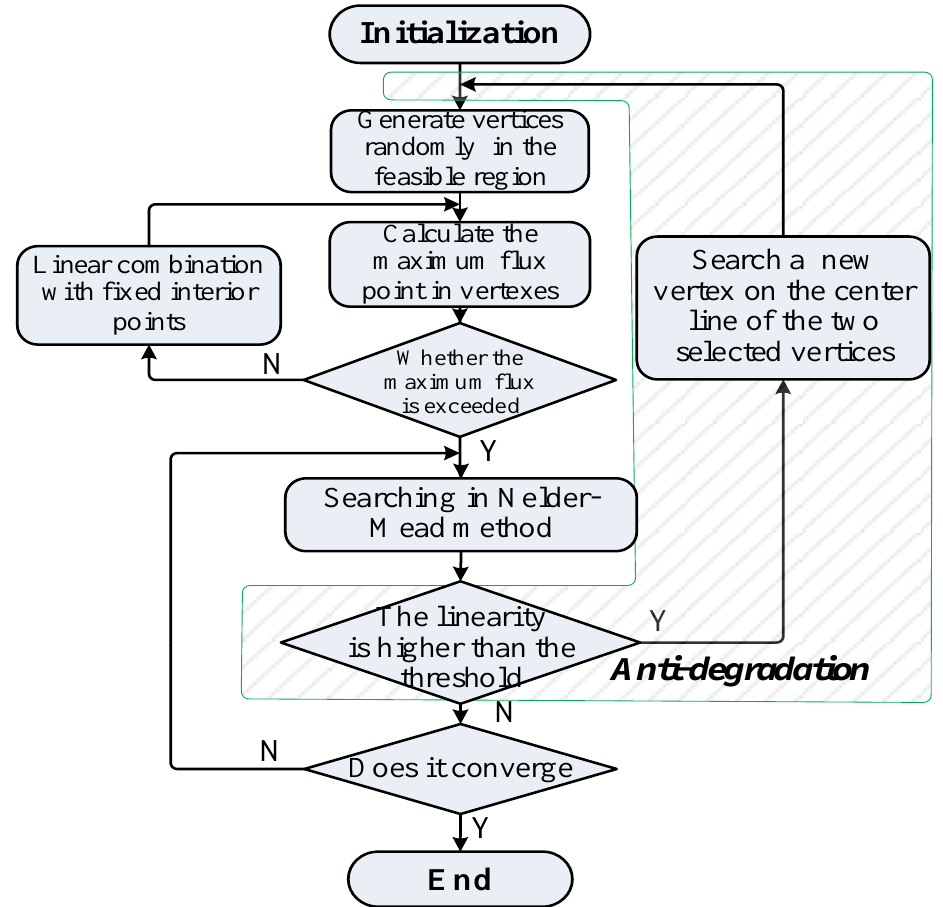
Figure 12. Main flow of improved NMS search method after improvement. Torque estimation and angle optimization units are shown in Figure 13. The optimal method for the current angle uses an online estimate d d-axis flux ˆ ψ d , then minus its output to the highest ambient temperature for d-axis flux ψ H , to obtain the temperature caused d by d-axis flux deviation ∆ ψ d . The torque estimator with a wide temperature range can be obtained by using the flux deviation and d-q axis current offline experiments at different temperatures. When the searching unit works for optimal current angle, a torque model is used to calculate the two torque estimates that increase/decrease the current angle of the current vector in the same step, and the relationship between the two is compared to determine whether the applied current angle is optimal. The procedure is shown in Figure 14. The obtained d-axis flux error ∆ ψ d includes the temperature-induced torque error, and achieves that the flux input to the torque estimator is independent of the optimal current angle, and the online optimization is simplified significantly. In addition, the actual motor temperature changes very slowly, so the iteration frequency of the torque compensation unit is very low, which does not require the excessive computational